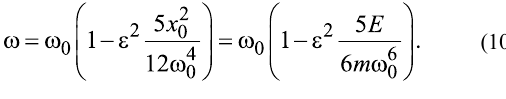
The tip parameters have been chosen as before ( T = 500 nK, N = 5 × 10 5 , ω 0 = 2 π × 50 Hz) with an anharmonicity ε = 2 × 10 8 m − 1 s − 2 . Figure 2a shows the distribution function as derived from a full numerical simulation at